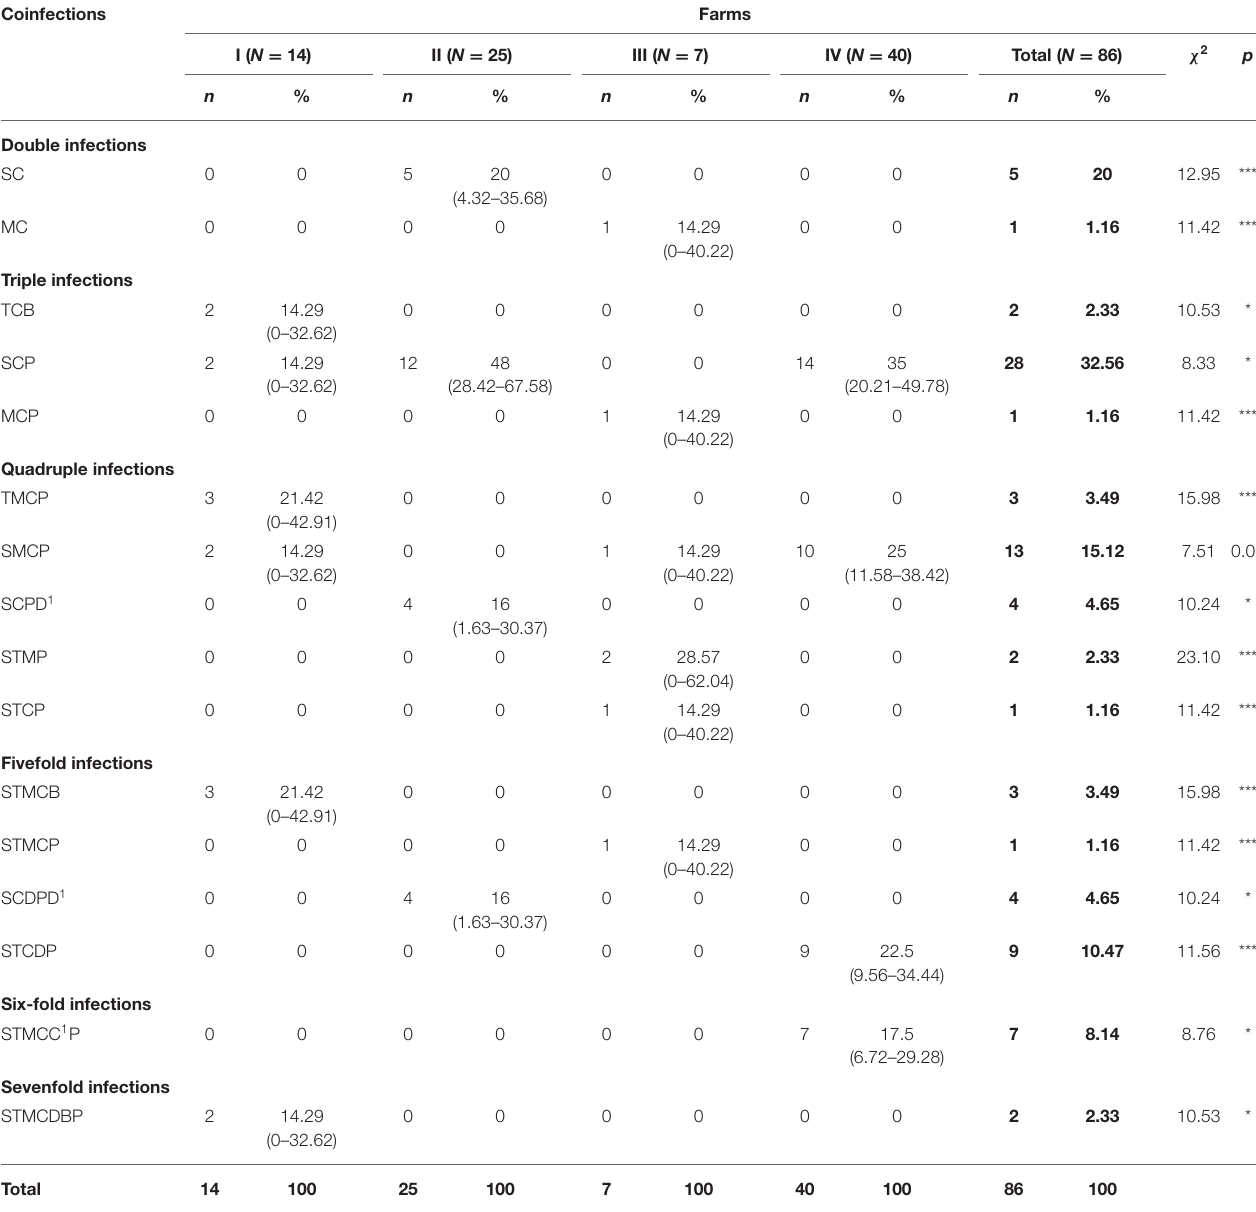
TABLE 5 | Prevalence of coinfection parasite infections in goats examined in four farms in Serbia.